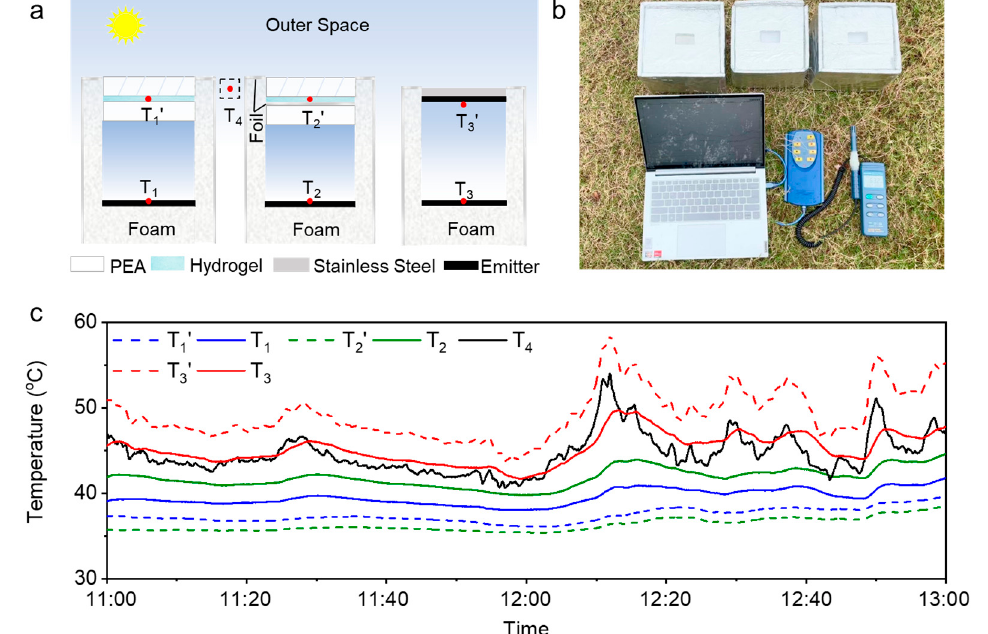
Figure 5. Demonstration of the cooling performance of the PHP membrane in outdoor conditions. ( a , b ) Schematic ( a ) and photograph ( b ) of the experimental setup. ( c ) The temperatures of the PHP sample (blue line, T 1 and T 1 ’), the PHP-foil sample (green line, T 2 and T 2 ’), the stainless steel sample (red line, T 3 and T 3 ’), and ambient (black line, T 4 ) from 11:00 to 13:00 7 July 2022 in Wuhan, China.